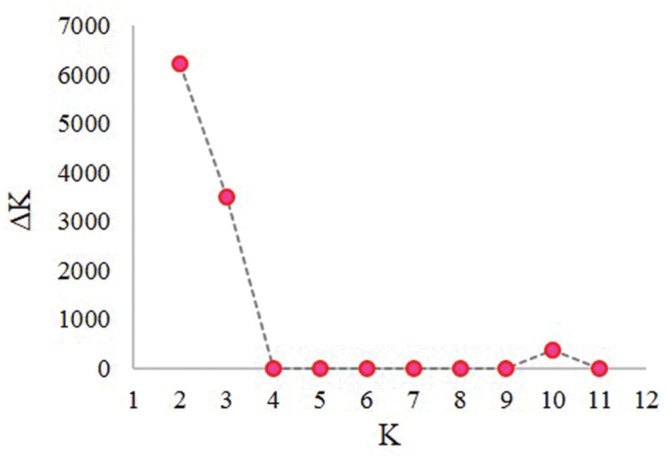
Plot of change in likelihood of the data, L(K), at values of K from 1 to 11, used to infer the true value of K following the method of Evanno et al. (2005).